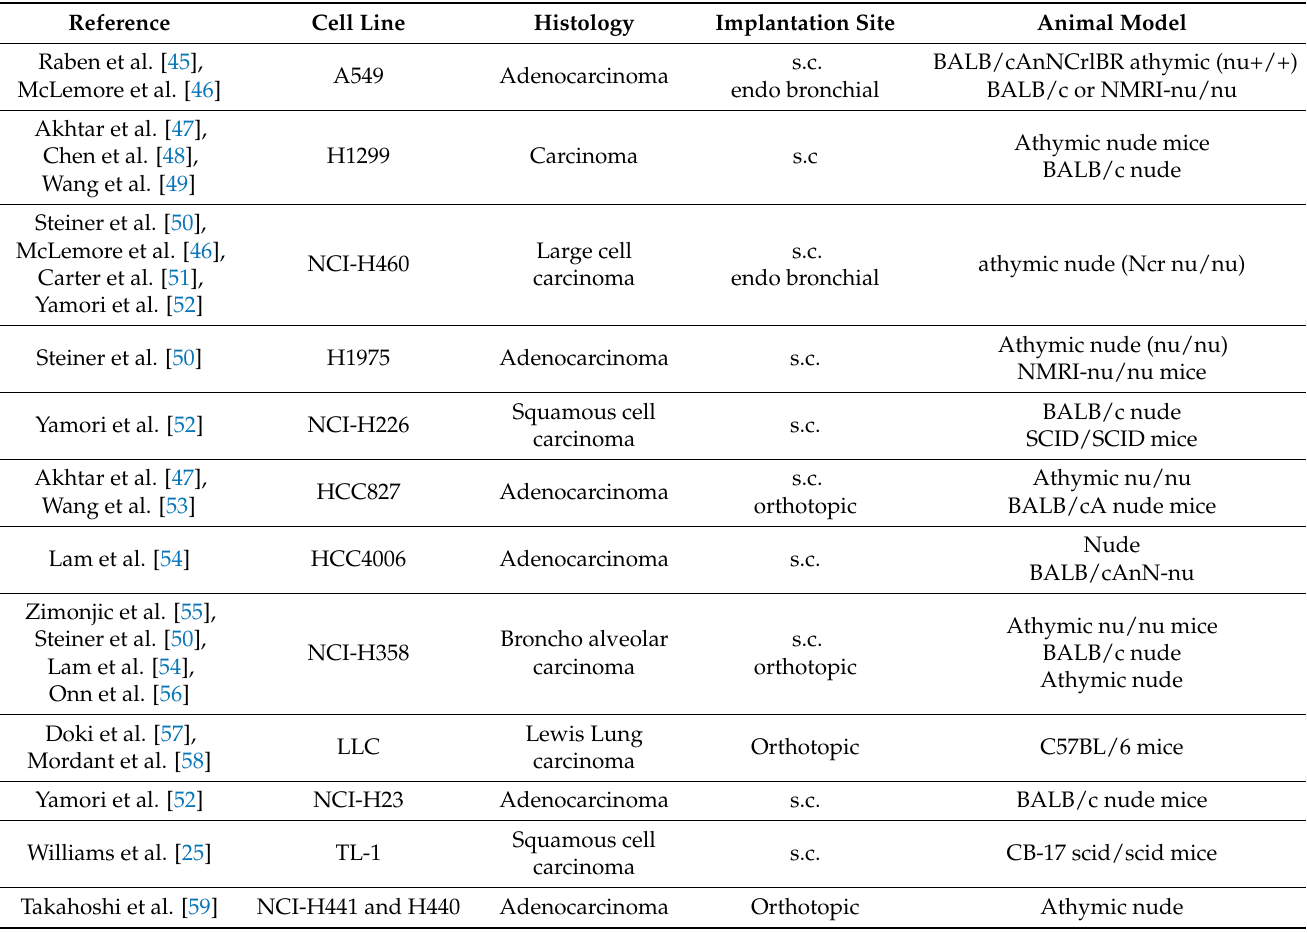
Table 1. Preclinical models of